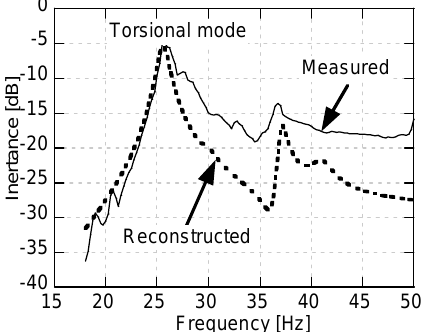
Fig. 12. RC-FE, FRF of point P on the handlebars.